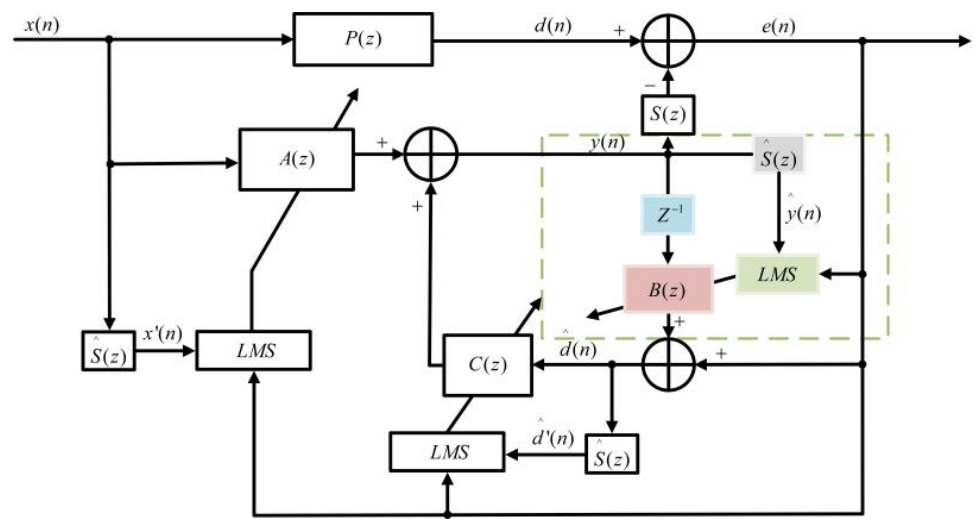
Figure 4. The improved EE adaptive IIR-filter-based ANC algorithm.